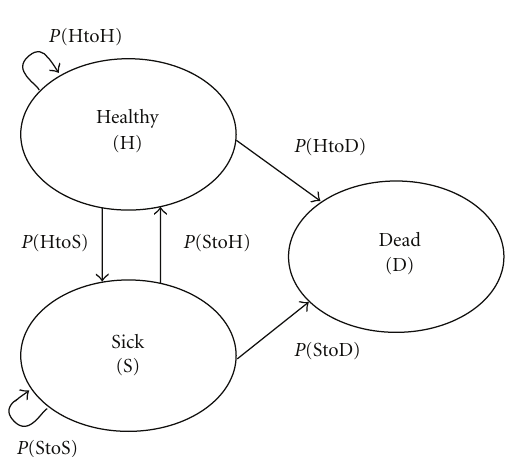
Figure 1: Transition probability model, showing the probability of remaining in a state or moving to another state during specific time intervals (such as one